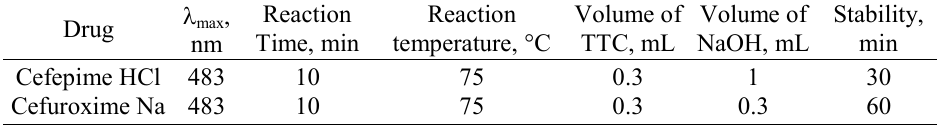
Table 1. Analytical data for determination of investigated drugs.